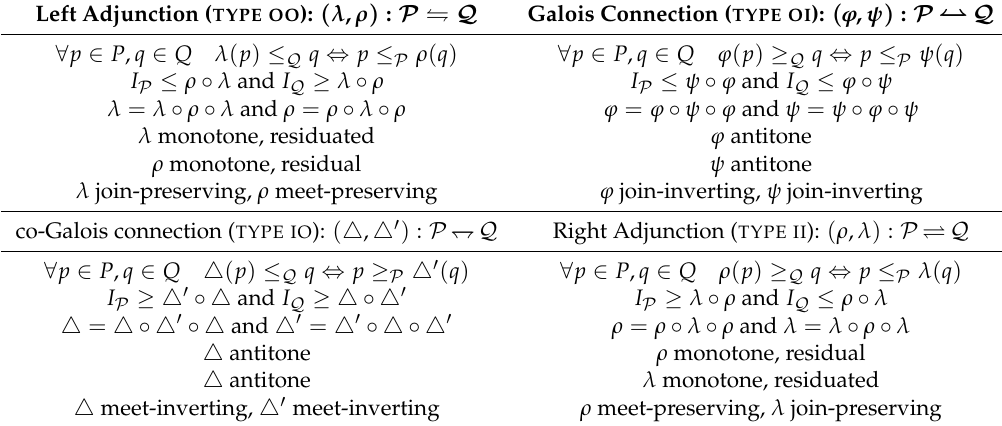
Table A2. Summary of Galois connections and their properties, for P , Q